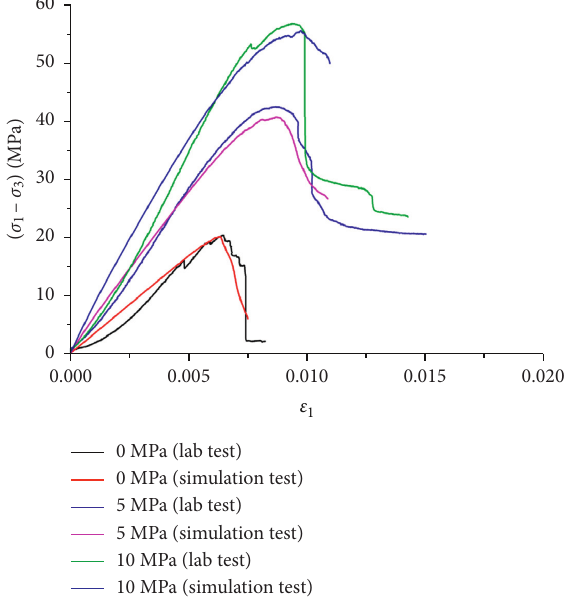
Figure 3: Comparison of simulating stress-strain curves and lab test curves (the loading rate of 0.02m/s). Symbol σ 3 represents the confining pressure.